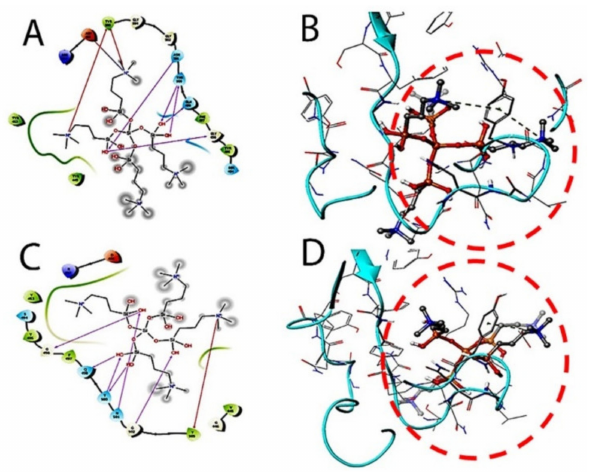
Figure 4. The induced fit pose 1 ( A , B ) docking active ligand with Glide using van der Waals removing side chains during the k21/quaternary ammonium silane docking step. The induced fit pose 2 ( C /2D, D /3D) was used to accommodate the ligand by reorientation of the side chains with low energy proteins ranked according to Glide